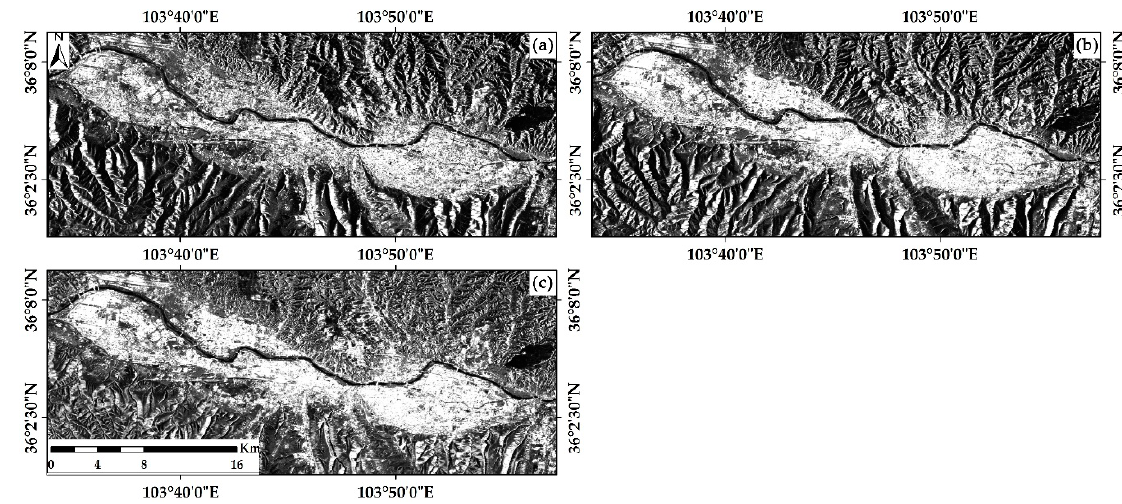
Figure 12. The difference comparison between ascend orbit SAR image ( a ), descend SAR data ( b ), and fused ascend/descend orbit SAR image ( c ).